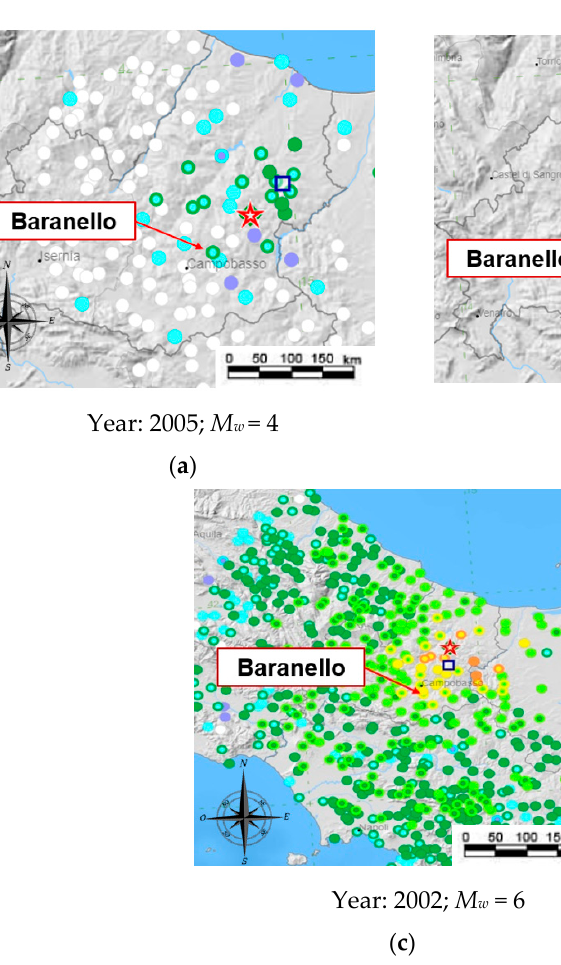
Table 3. The correlation between moment magnitude, M w , and macroseismic intensity, I EMS-98 .